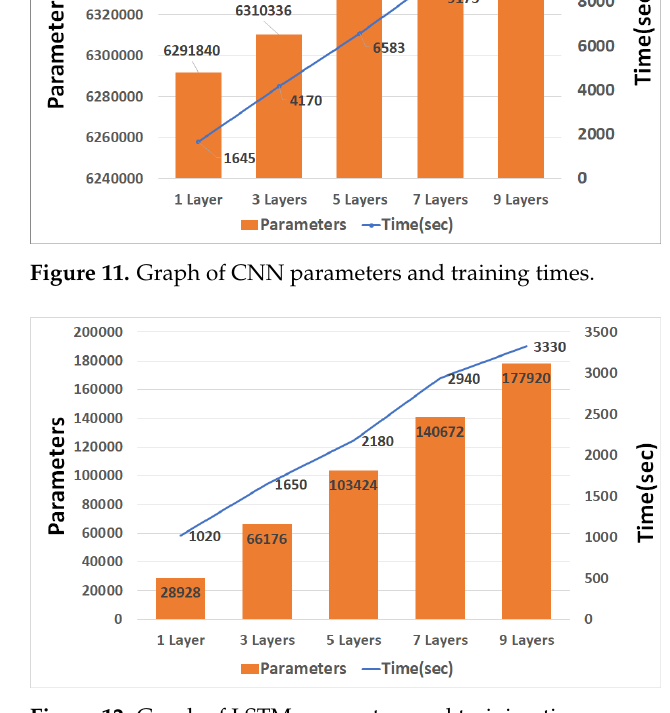
Figure 12. Graph of LSTM parameters and training times.